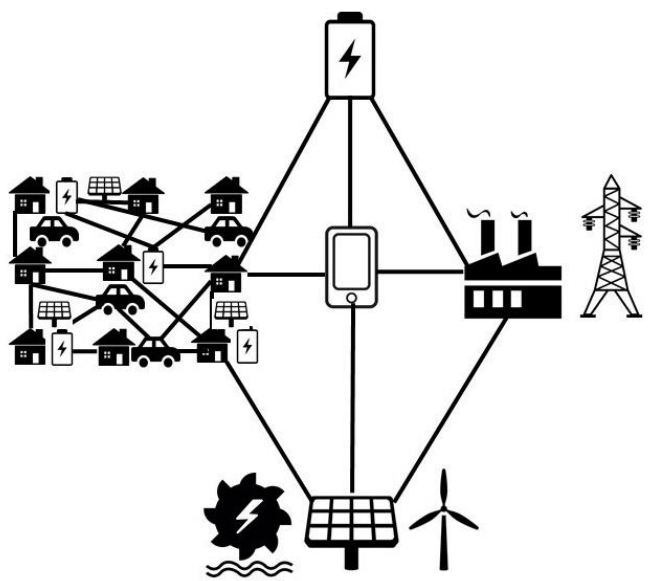
Figure 3. Information and communication technology (ICT) in effective energy management. Source: created by the authors .